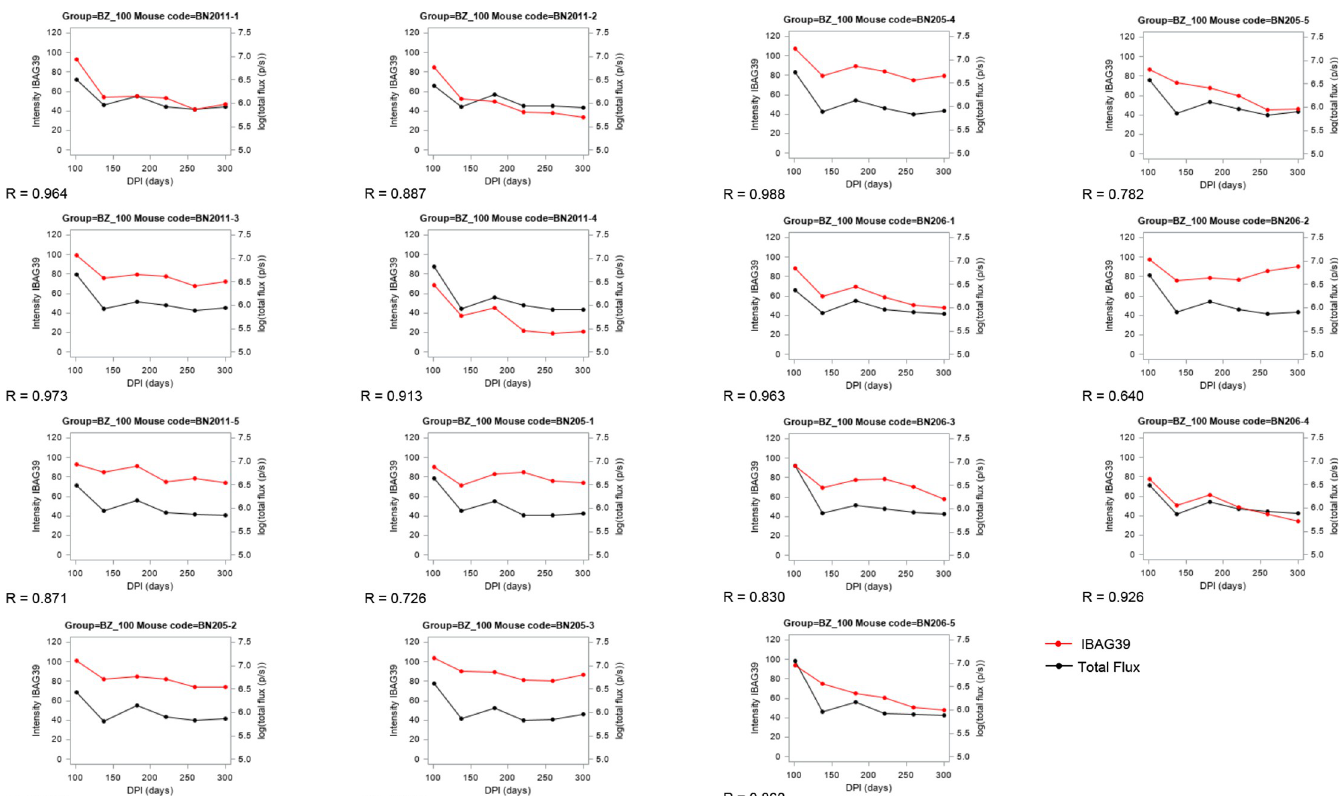
Fig 5. Bioluminescence total flux and IBAG39 intensity of reactivity for each of the 15 mice treated with 100 mg kg -1 benznidazole (BZ). The linear correlation coefficient R is given in each graph. The red curve is intensity of IBAG39 and the black curve is log (total flux (p/s)).